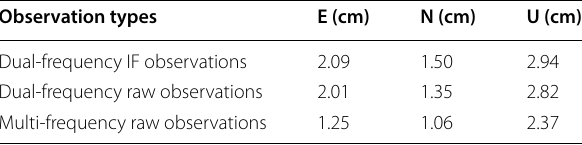
Table 4 Averaged RMS values for the E, N, and U components for different multi-GNSS PPP solutions Observation